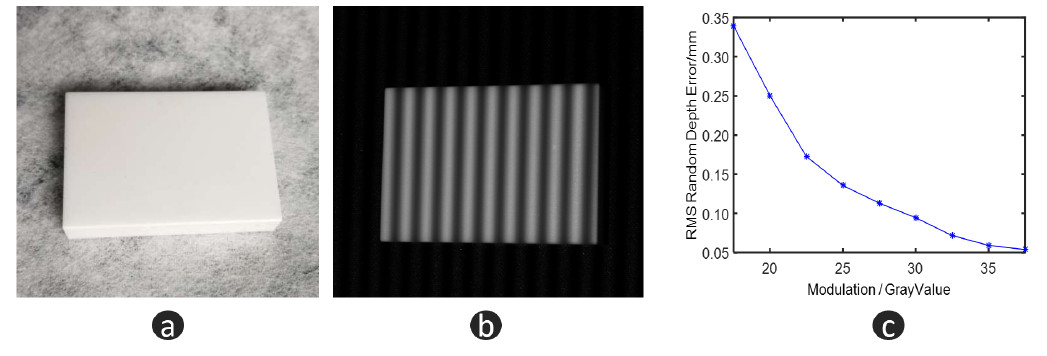
Figure 8. Depth reliability experiments. ( a ) standard gauge block; ( b ) standard gauge block with fringe pattern; and ( c ) the relationship between modulation and measurement